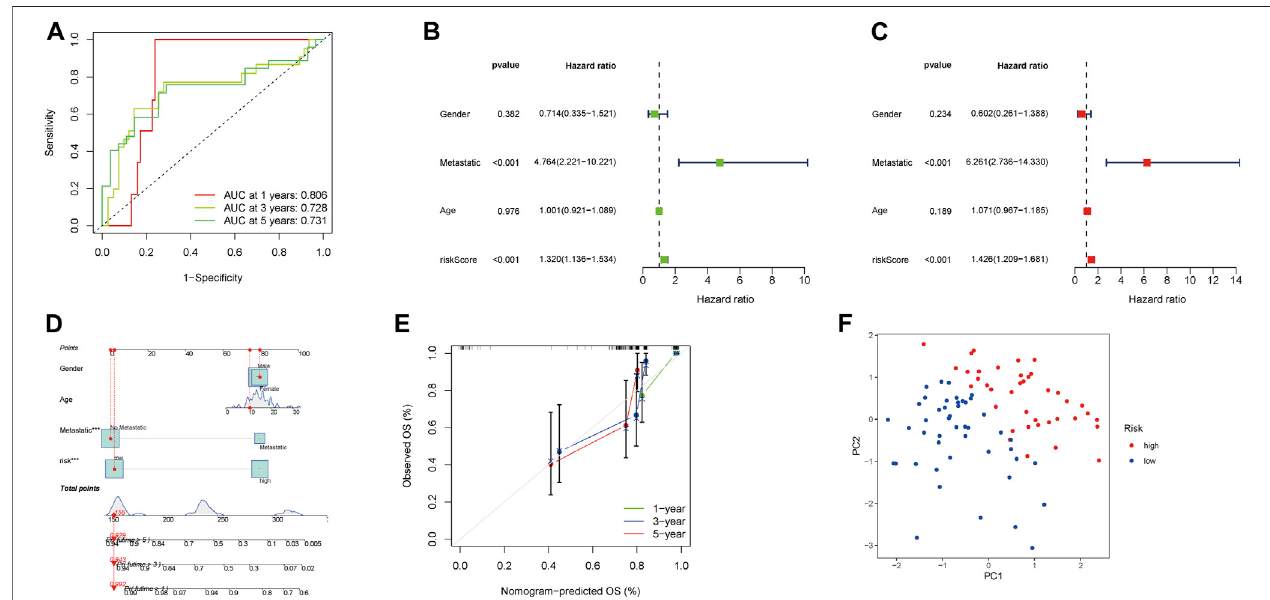
FIGURE 4 | Assessment and nomogram of the necroptosis-related lncRNA signature. (A) 1-, 3-, and 5-year ROC curves of the entire sets. (B – C) Uni-Cox and multi-Cox analyses of clinicopathologic factors and risk score with overall survival. (D) Nomogram for predicting overall survival. € 1-, 3-, and 5-year overall survival of calibration curves. (F) PCA scatterplot of the sample